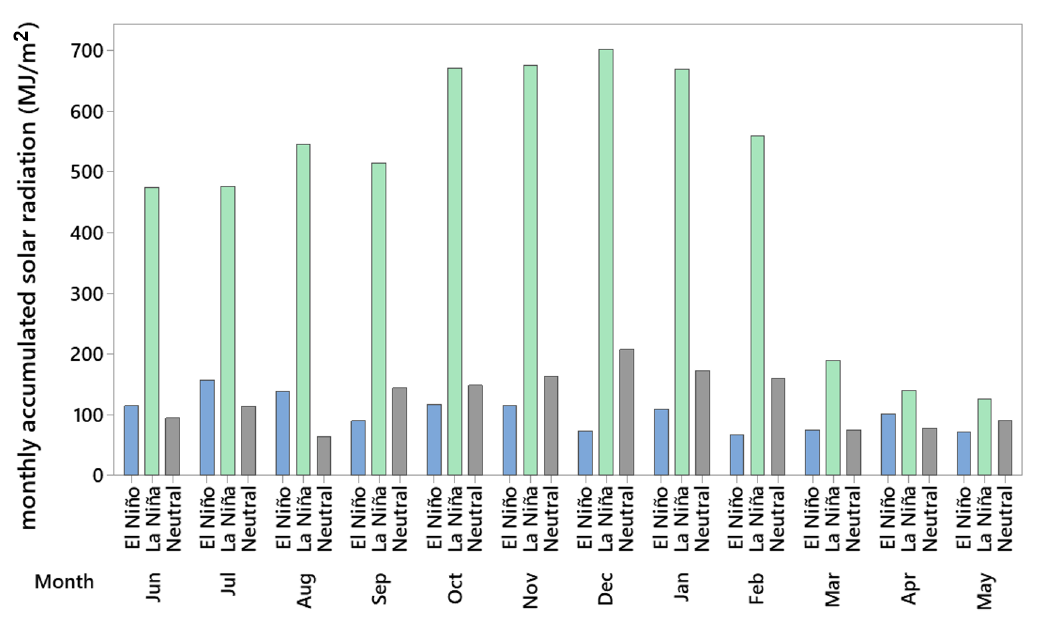
Figure 7. Monthly accumulated solar radiation for the city of Coxim. The accumulated solar radiation value is much higher in La Niña (2010–2011) than in other periods.